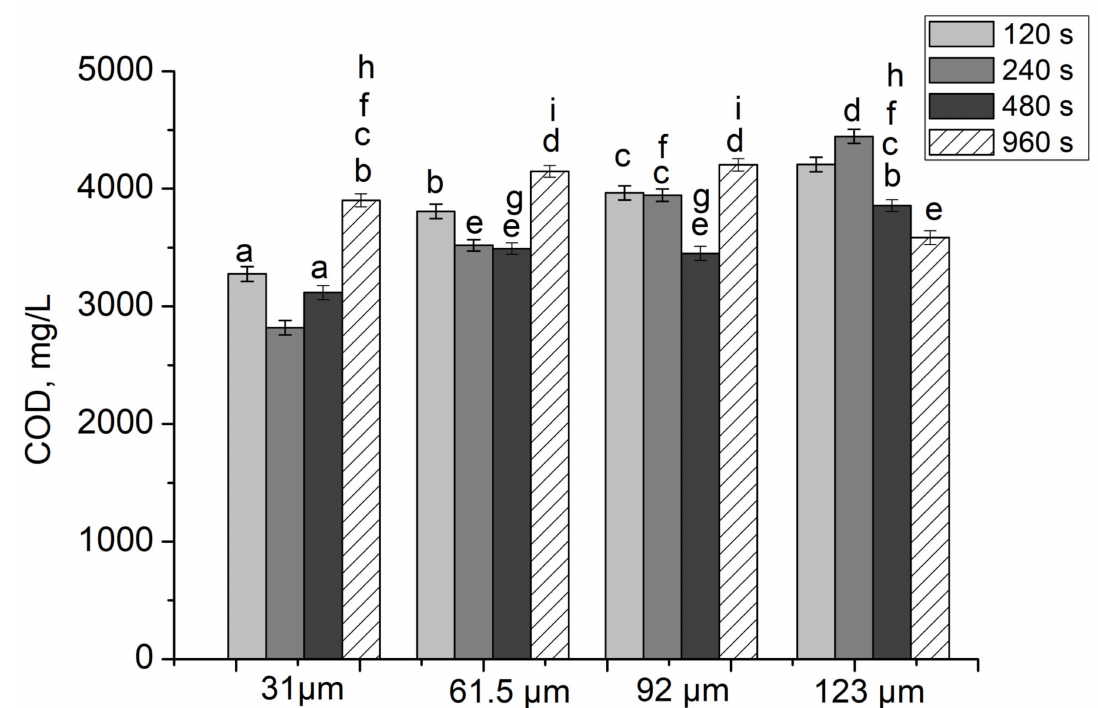
Figure 2. The influence of sonication time and the magnitude of the vibration amplitude on the chemical oxygen demand (COD) value of coke wastewater (Statistical group a–i).